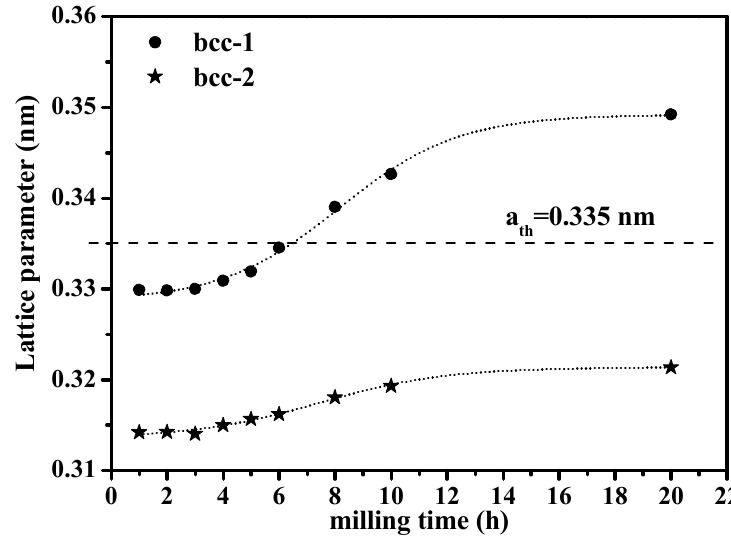
Figure 2. Experimental lattice parameters of bcc-1 and bcc-2 phases for all pTNTMZ specimens milled between 1 and 20 h. Dashed line shows the theoretical lattice parameter for a unique TiNbTaMoZr HEA, calculated by the mixing law.